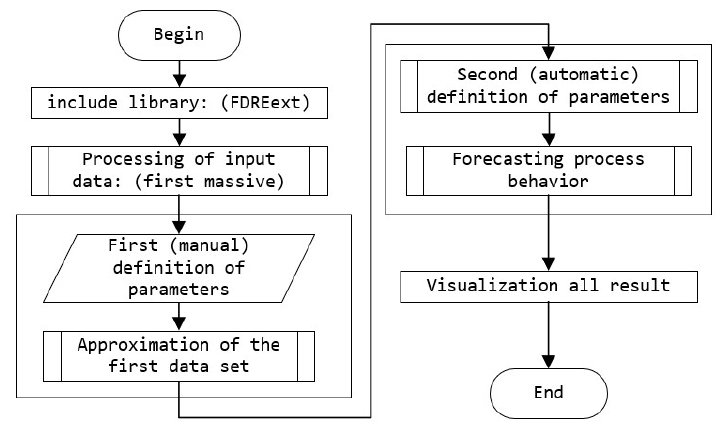
Figure 8. Block diagram, executable file for SA simulation